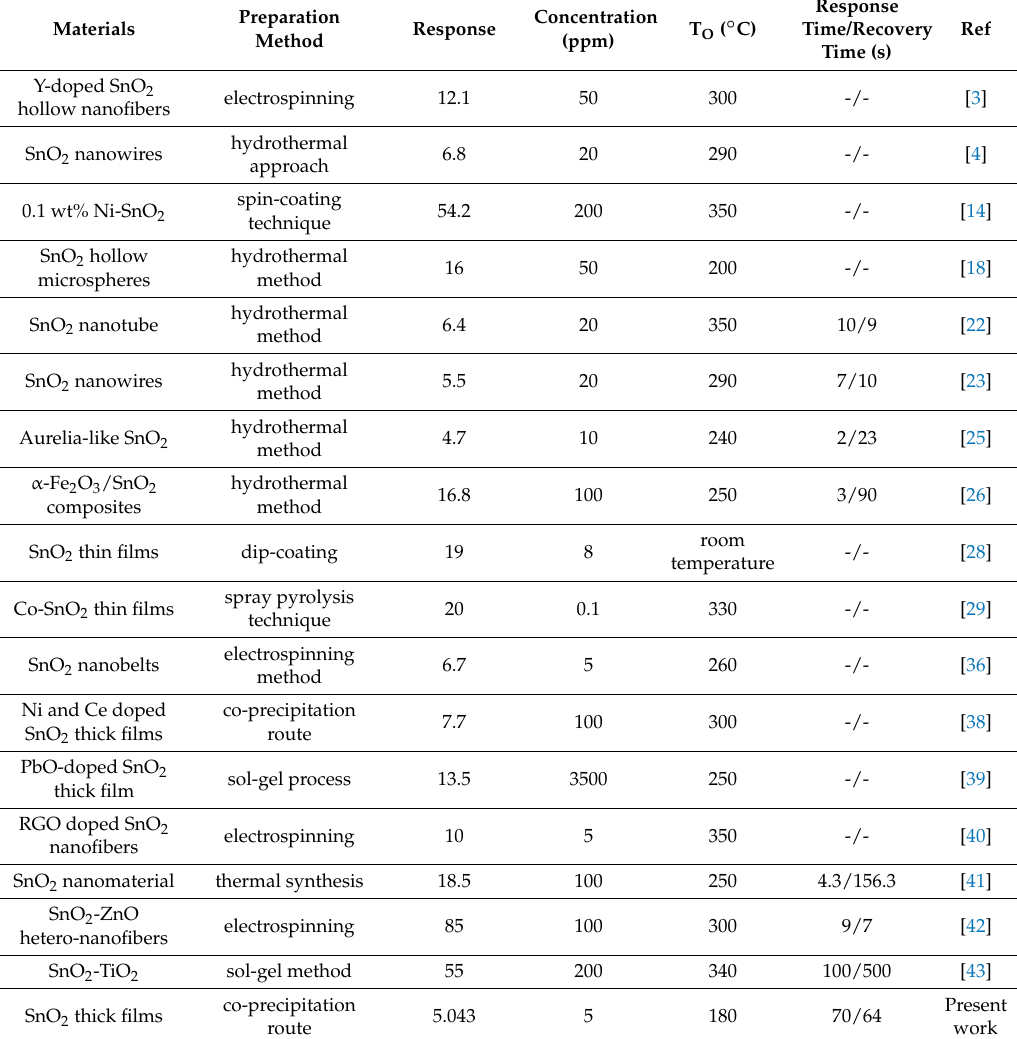
Figure 6. The dynamic sensing characteristics of the SnO 2 sensor exposed to 5 ppm, 10 ppm, 20 ppm and 50 ppm acetone at an operating temperature of 180 °C. Table 2. Acetone sensing properties for various SnO 2 semiconductor